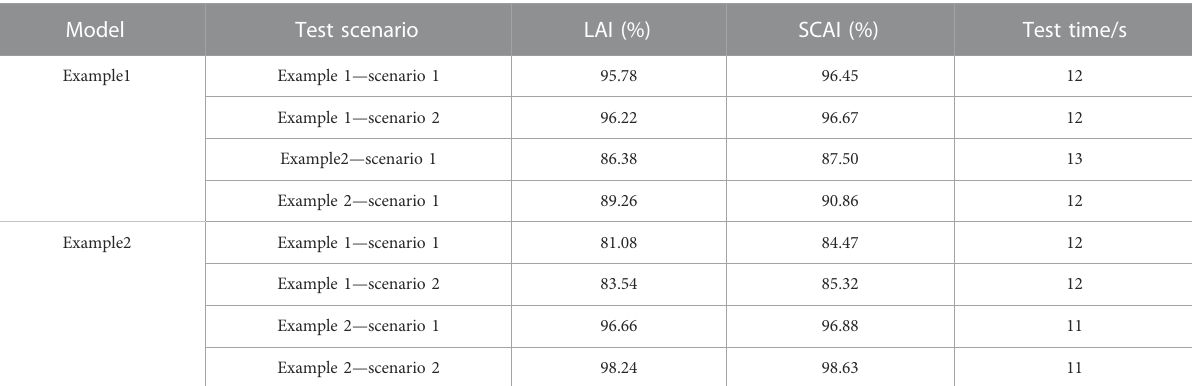
TABLE 2 Test results with two